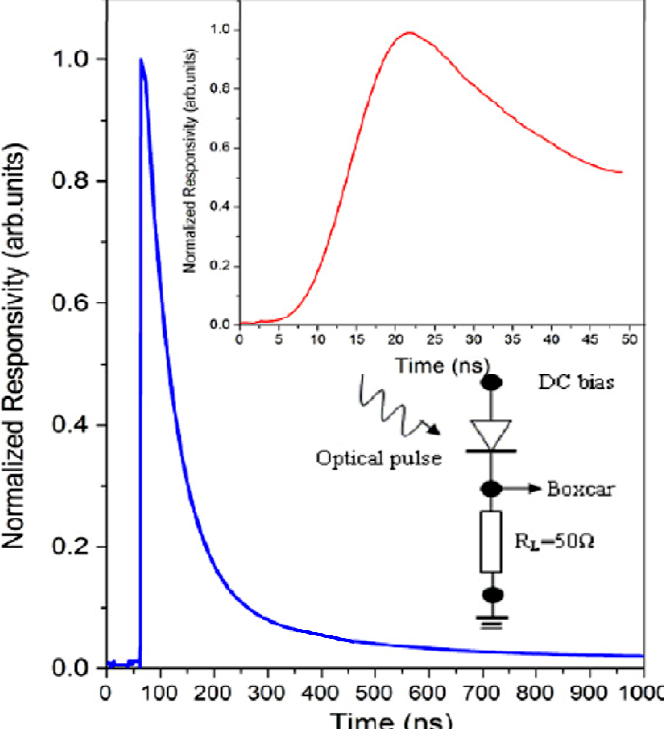
Figure 18. Normalized pulse response measurement of the Zn excited by Nd-YAG laser pulses (266 nm, ~10 ns)